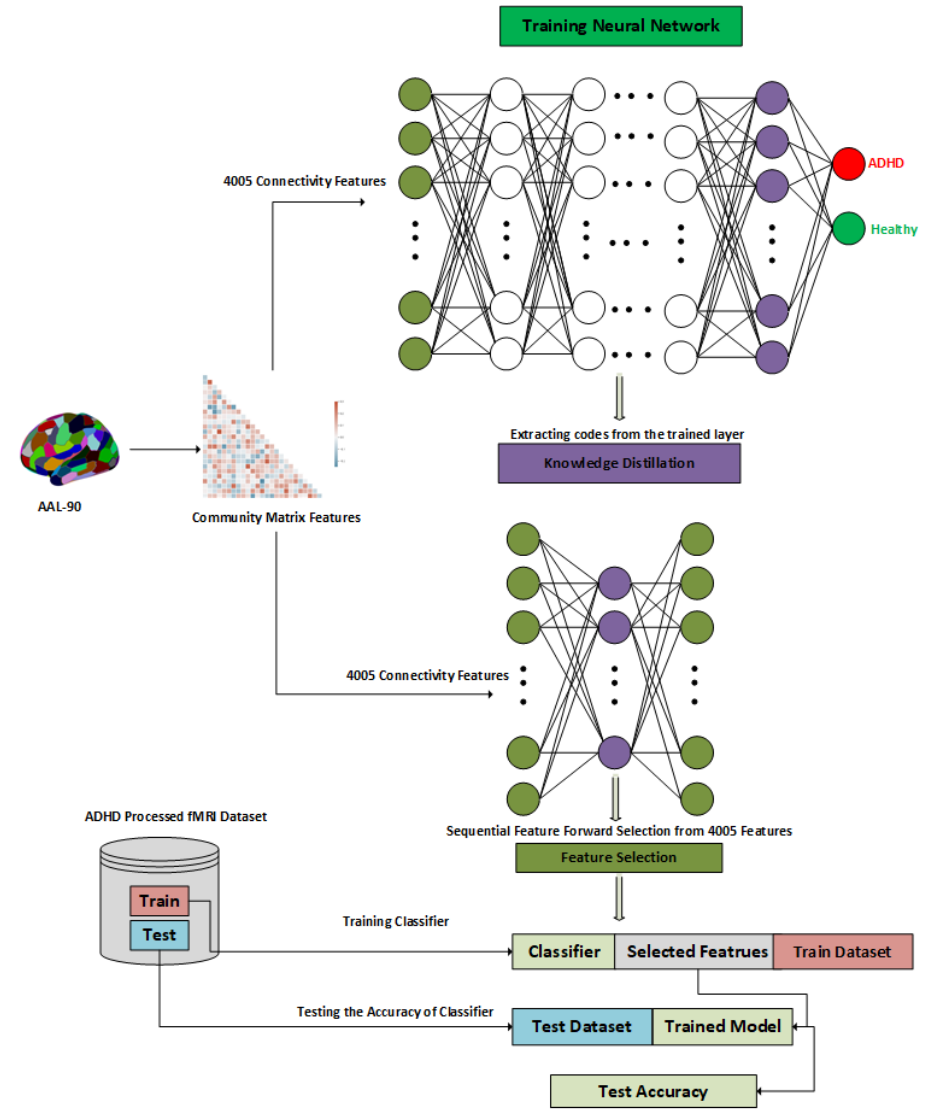
Figure 1. Proposed architecture of the feature selection